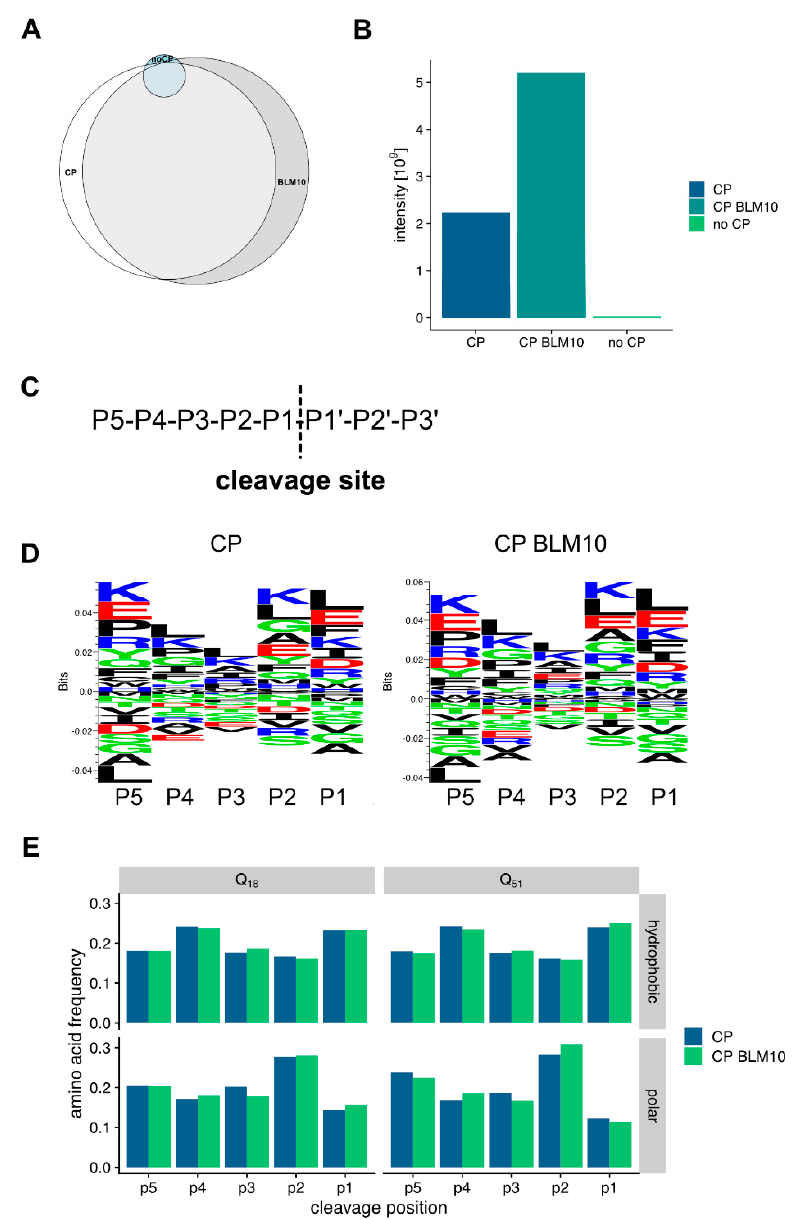
Figure 8. Characterization of the CP and CP BLM10 generated Htt peptides. ( A ) Venn diagram showing the overlap of peptides identified in the in vitro Htt degradation experiment. A total of 71% of the identified peptides are shared between CP and Blm10-CP based degradation. ( B ) Blm10-CP has a higher processivity for the generation of peptides. More peptides were generated at the same time from the Blm10-CP complex. ( C ) Scheme of the cleavage description. ( D ) Sequence logos of the peptides generated by the CP and Blm10-CP complex. ( E ) Amino acid frequencies for hydrophobic and polar amino acids at the di ff erent cleavage